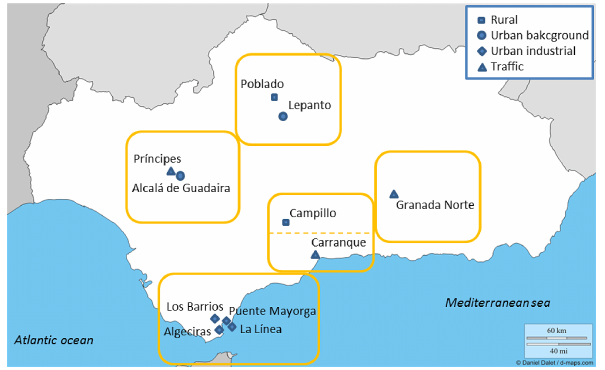
Fig. 1. Map of the 11 monitoring sites (divided into six zones) used for the PM source apportionment